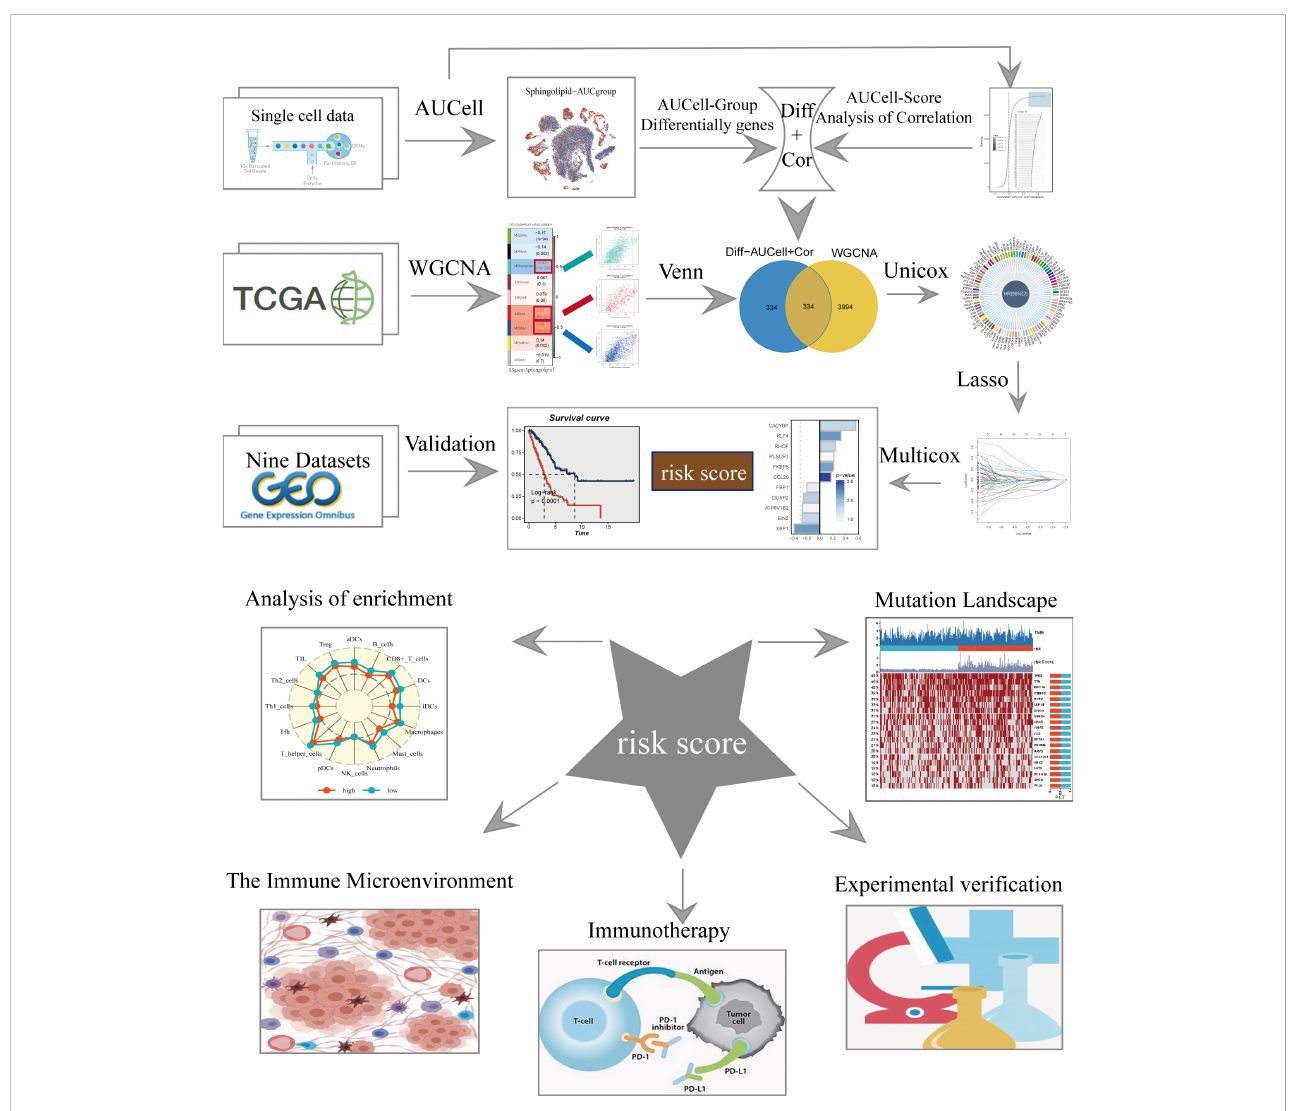
FIGURE 1 The fl owchart of this